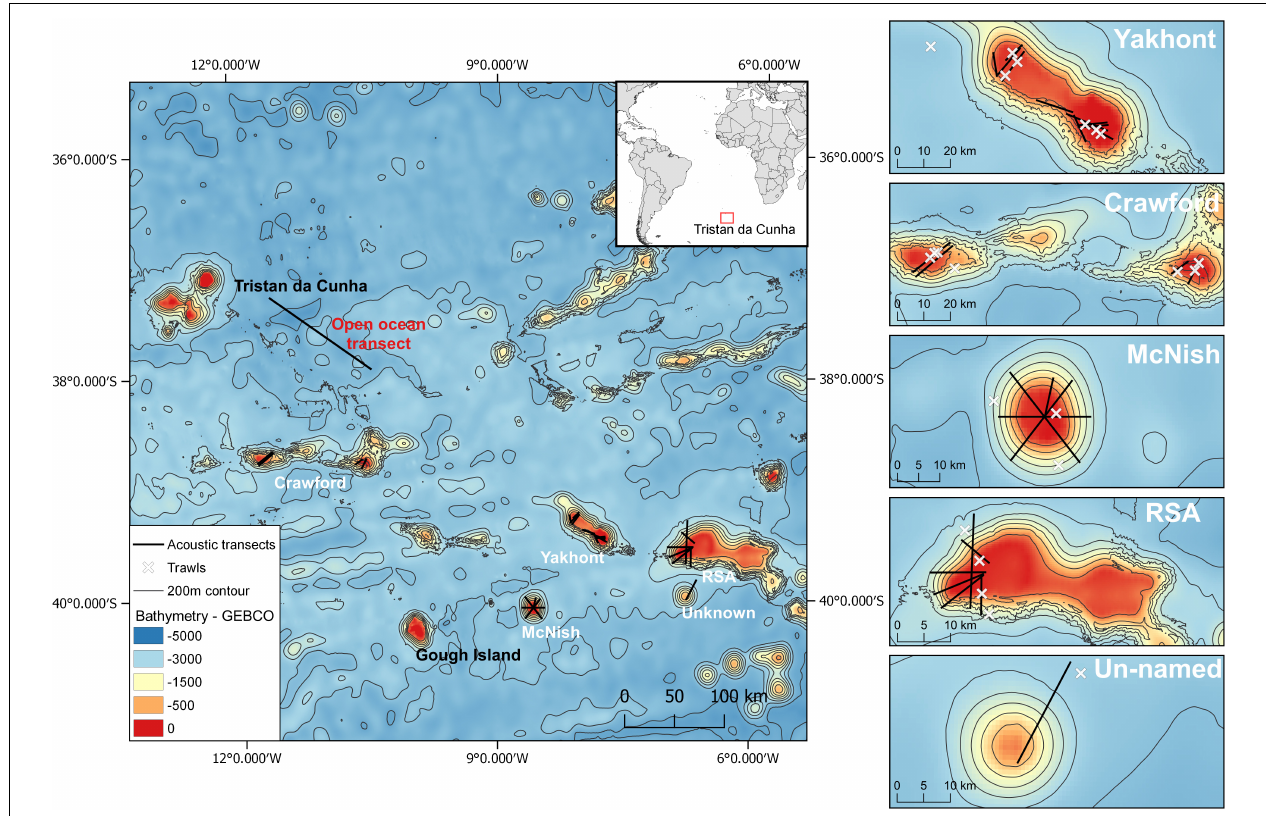
FIGURE 1 | Overview of study area (left), with detailed maps of the seamounts (right), including acoustic transects and net trawls (see legend), conducted during the 2018 (Yakhont and Crawford seamounts) and 2019 expeditions (McNish, RSA and un-named seamounts, open ocean